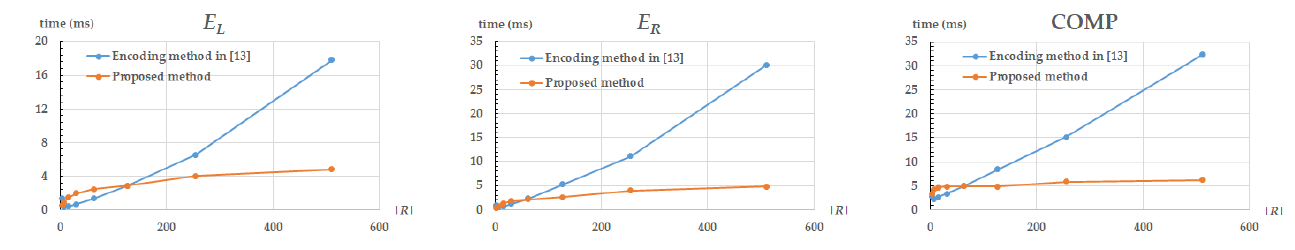
Figure 10. Comparison of the computation times of the E L , E R and COMP on the DSO.